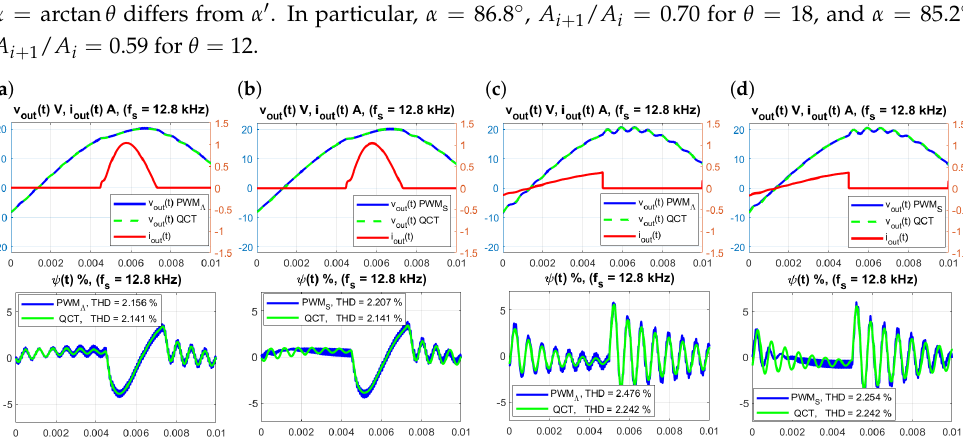
Figure 25. Plots of v out ( t ) , i out ( t ) and ψ ( t ) for the rectifier RC load and abruptly changing resistive load in a 1Ld(PID) system at 12.8 kHz using PWM Λ and PWM S modulation. ( a ) PWM Λ , rectifier load; ( b ) PWM S , rectifier load; ( c ) PWM Λ , resistive load; ( d ) PWM S , resistive load. The presence